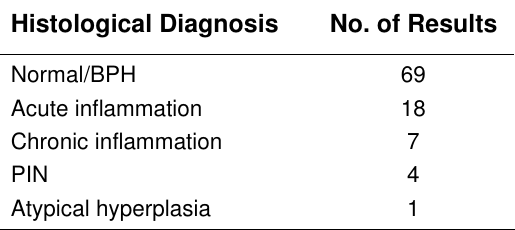
Benign Histological Results for the 99 Patients Included in the Analysis